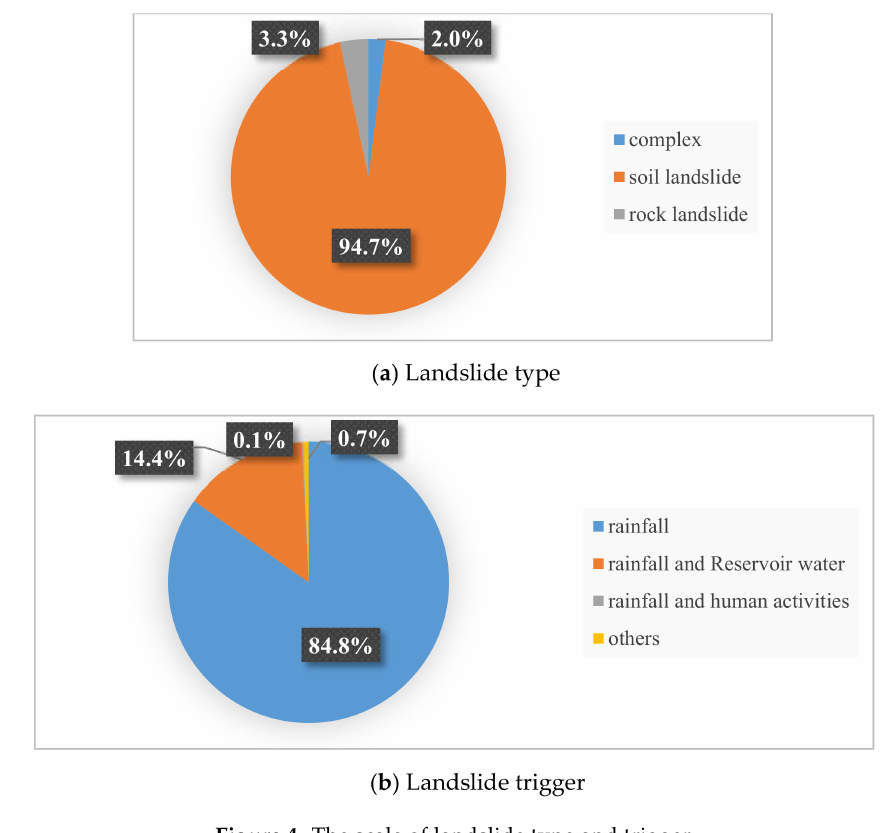
Figure 4. The scale of landslide type and trigger.